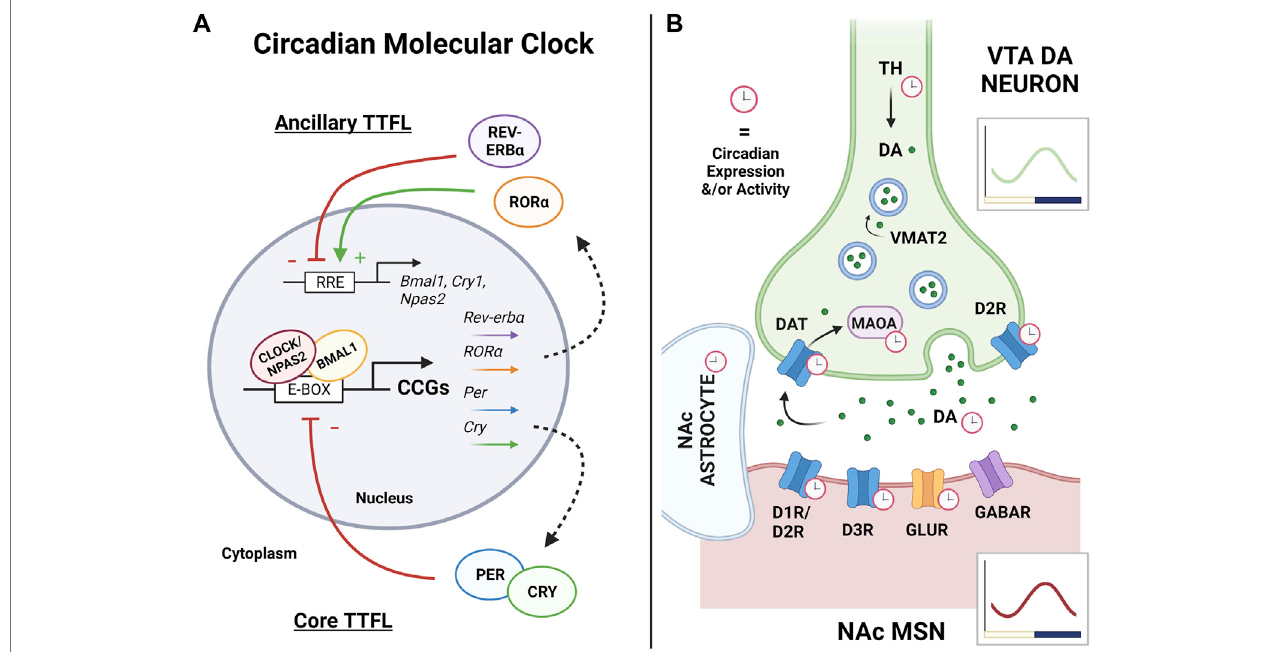
FIGURE 1 | The circadian molecular clock and its regulation of the VTA-NAc synapse. (A) Rhythms of the circadian molecular clock are generated through a complex series of transcriptional-translational feedback loops (TTFLs). In the mammalian core TTFL, CLOCK (or its functional paralogue NPAS2) forms a heterodimer with BMAL1, binds to E-box elements in the promoter regions of DNA, and drives the transcription of many clock-controlled genes (CCGs), including Period and Cryptochrome. Throughouttheday,PERsandCRYsaccumulateinthecytoplasm,dimerize,andundergophosphorylation.Intothenight,PER:CRYdimersshuttle back into the nucleus and inhibittheir own transcription through repressing CLOCK/NPAS2:BMAL1 activity, thus completing the core TTFL which cycles approximately every 24 h. Among its CCGs, CLOCK/NPAS2:BMAL1 also regulates the expression of the nuclear receptors ROR α and Rev-erb α which form an ancillary TTFL of the molecular clock. ROR α and REV-ERB α compete at Rev-erb/Ror response elements (RREs) in the promoter regions of Bmal1 , Npas2 , and Cry1 to regulate their transcription,whereROR α promotesexpressionandREV-ERB α represses.Alongwithothers,thisancillaryTTFLworkstosustain,stabilize,andreinforcethecoreTTFL andrhythmicoutputasawhole,altogethertemporallycontrollingnearlyallaspectsofcellularphysiology.Arrowsand(+)indicatepromotionofexpression,whilebarsand ( − )indicaterepressionofexpression. (B) Theventraltegmentalarea(VTA)andnucleusaccumbens(NAc)circuitisthekeyrewardpathwayofthebrain.Rewardingstimuli primarilystimulatedopamine(DA)neuronsintheVTAtoreleaseDAintotheNAc,drivingmediumspinyneuron(MSN)activityandsubsequentreward-seekingbehaviors. The circadian molecular clock has been shown to regulate nearly all components of DA synaptic transmission, with synthesis, uptake, and degradation all showing circadian variation in expression or activity. This includes the synthesis enzyme tyrosine hydroxylase (TH), the DA receptors (D 1 R, D 2 R, and D 3 R), DA release itself, the dopamine reuptake transporter (DAT), and the dopamine degradation enzyme monoamine oxidase A (MAOA). Overall rhythms in activity, molecular clock genes, and transcriptome wide rhythms have been detected in the VTA and NAc, with peaks aligning in the active phase (dark phase in nocturnal rodents). Robust rhythms have been detected in NAc astrocytes, as well as rhythms in GABA, glutamate, and glutamate receptors (GLUR) in the NAc. Red clocks indicate observed rhythms in expression or activity. Green dots are DA molecules. Vesicular monoamine transporter 2 (VMAT2) loads dopamine into the vesicles prior to synaptic release. Graphs illustraterepresentativewaveformofoverallVTA(green)orNAc(red)rhythmicityinnocturnalrodents,withyellowbarindicatinglightphaseandpurplebarindicatingdark phase. Figure created with BioRender.com.